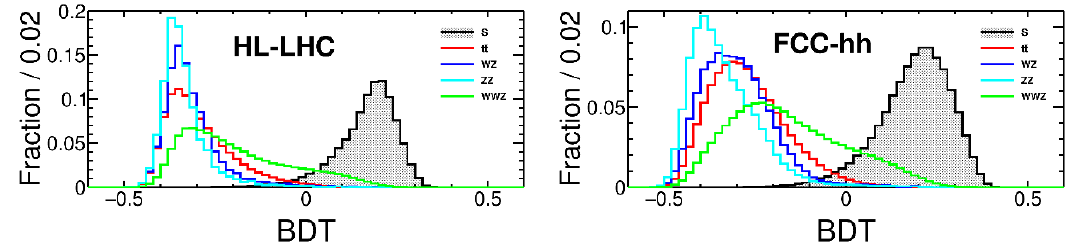
Figure 3 . Distributions of BDT response at the HL-LHC (left) and FCC-hh (right) for signal with M N = 500 GeV (S, black with (cid:12)lled area), and for SM backgrounds including t (cid:22) t (red), WZ (blue), ZZ (cyan), and WWZ (green).